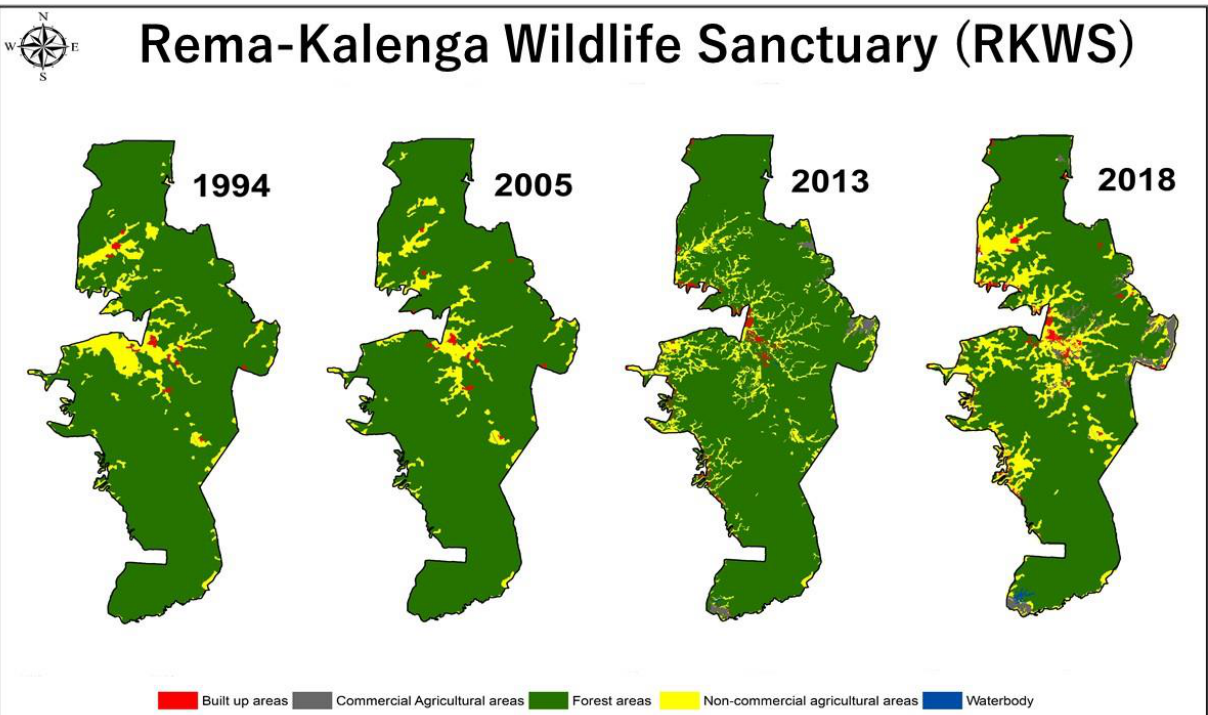
Figure 4. Temporal and spatial land use land cover changes in 1994, 2005, 2013, and